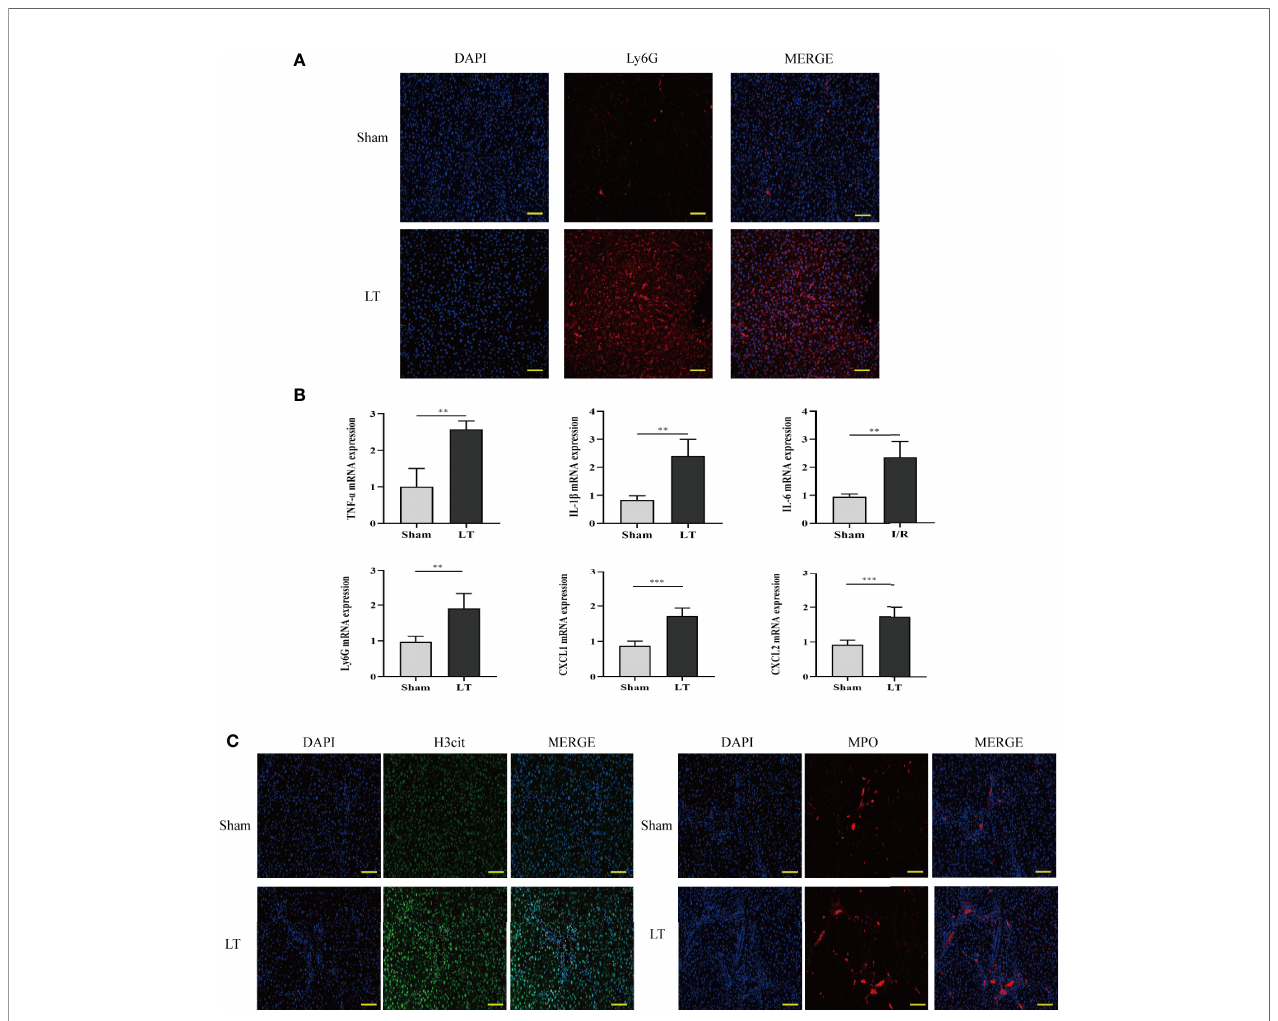
FIGURE 2 | Neutrophil in fi ltration and NET deposits in the liver induce an in fl ammatory response in the AR of liver transplantation rats. (A) Immuno fl uorescence assessment of the neutrophil marker (Ly6G) for labeling neutrophil locations in livers (magni fi cation, ×200; scale bar = 100 m m). (B) mRNA TNF- a , IL-6, Ly6G, IL-1 b , CXCL1, and CXCL2 levels in liver tissues. (C) Representative immuno fl uorescence micrographs demonstrating the co-localization of NET components, including H3Cit, DAPI, and MPO in the livers of liver transplantation rats (magni fi cation, ×200; scale bar = 100 m m). Data were analyzed by the Mann – Whitney test. Data are presented as mean ± SD (n = 6). ** P < 0.01, *** P <